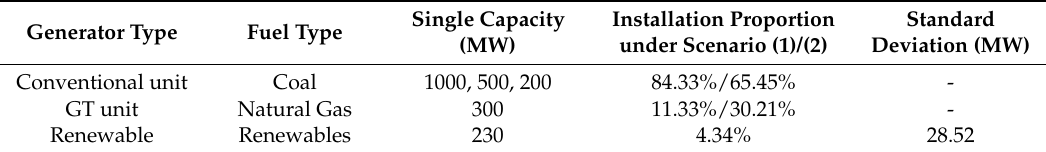
Table 1. Installation capacities of different types of generators.